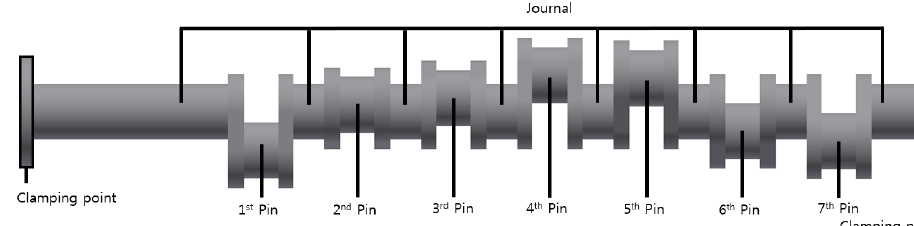
Figure 4. Modeling of the crankshaft.